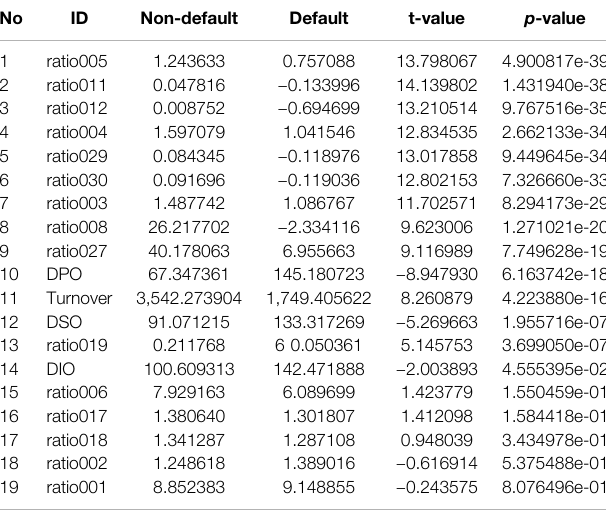
TABLE 2 | List of the 19 features/ratios used for loan default analysis, sorted ascending by the p -values calculated using Welch ’ s t